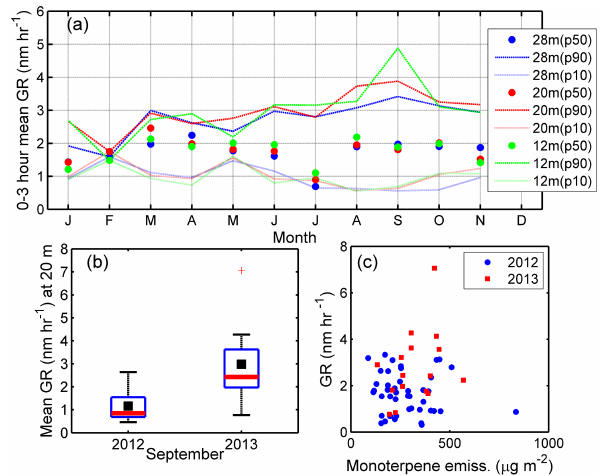
Figure 7. Summary of 3h average growth rates (GR) at the three sampling levels (28, 20 and 12m) during A-type NPF events. (a) Median, 10th and 90th percentile growth rates (GR) for the 3h after the minimum number geometric mean diameter (min(nGMD)) at the three measurement heights by calendar month. Note the in- strument was not operated at the site during April–July 2013 in- clusive, thus the data shown for May, June and July are reflective of conditions during 2012 only. (b) Box plots of 3h average GR for events during September 2012 and September 2013 (where the solid black square denotes the mean value). (c) Mean GR at 20m in the 3h after the nucleation mode min(nGMD) vs. the cumulative monoterpene emissions for the 3h preceding the min(nGMD) and the hour after min(nGMD), during events that occurred in 2012 and 2013 when the LAI